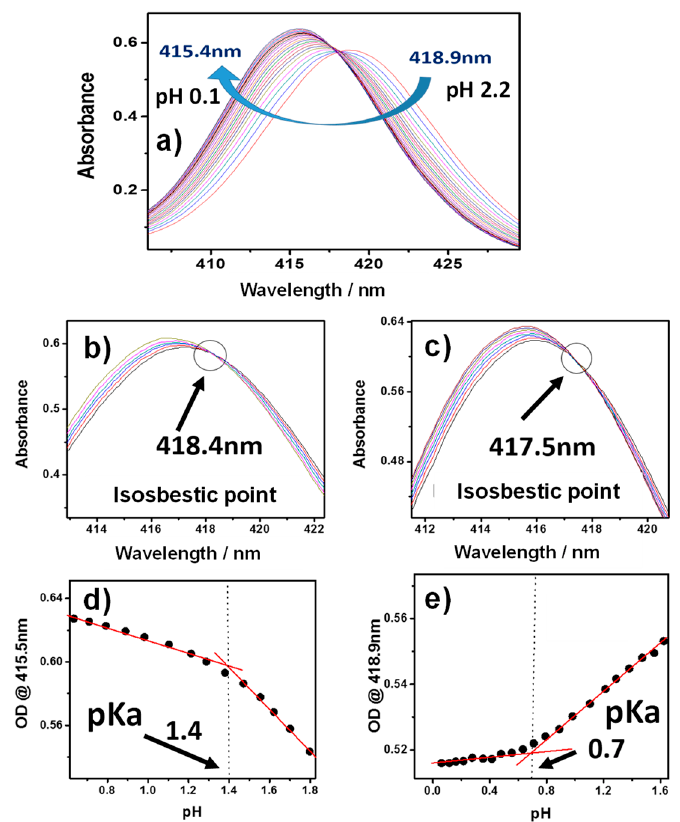
Figure 3. ( a ) The second blue shifting of the λ max (Soret band) of SnTPyP (1.4 × 10 − 6 M in CH 3 CN/H 2 O (8/2, v / v )) in the pH region 2.2–0.4, ( b , c ) isosbestic points (circle) observed in the pH region 2.2–0.4, ( d , e ) pKa values estimated from the inflection points in the plots between pH vs. OD in the pH region